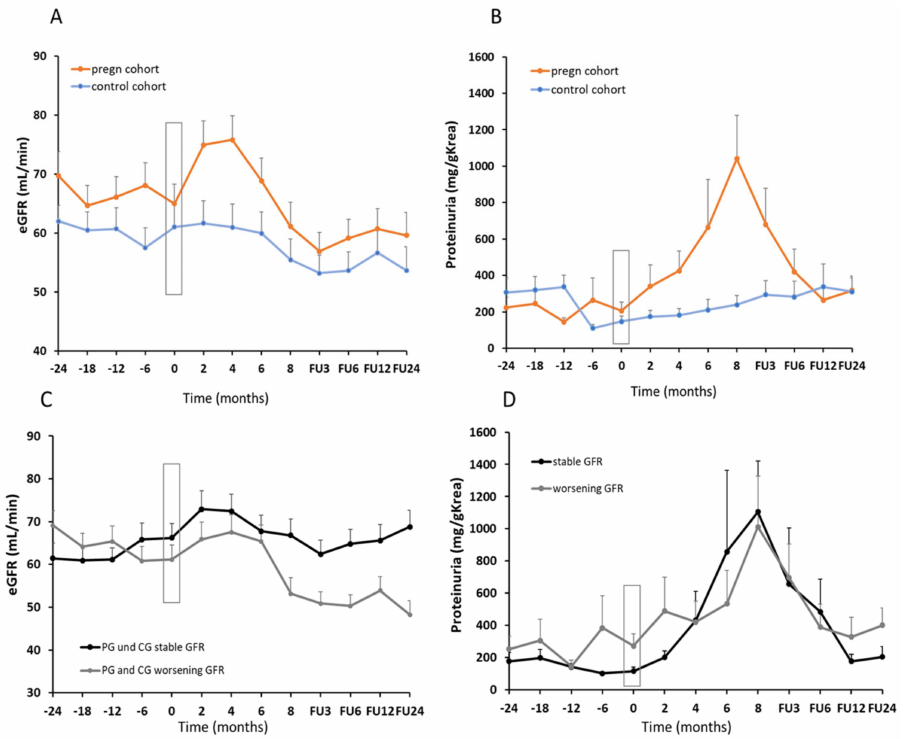
Figure 2. GFR slopes pre-pregnancy and follow-up in women with post-transplant pregnancies (pregn cohort) compared to a control cohort. GFR slopes ( A ) and the course of proteinuria ( B ) in all post-transplant pregnancies and matched controls. GFR slopes in all kidney transplant recipients (KTR) subdivided into KTR women with stable (black line) or worsening (gray line) allograft function over time ( C ). Change in proteinuria during post-transplant pregnancies in women with stable (black line) or worsening (gray line) allograft function over time ( D ). Table 4. Allograft outcome in post-transplant pregnancies and